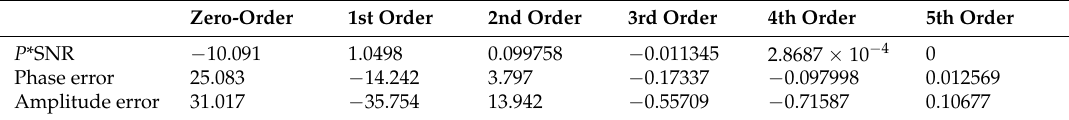
Table 2. Polynomial approximation of the SR factors as a function of P *SNR, phase error and amplitude error.